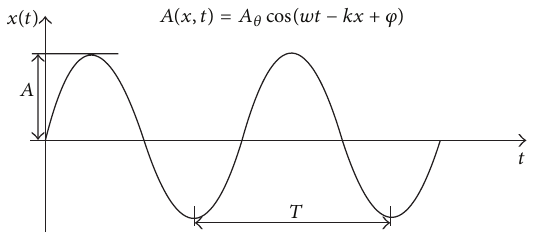
Figure 2: Phase shift measurement system operation principle, where the distance is calculated comparing the phase difference between the emitted pulse and the return pulse. Modified from San Jose Alonso et al.